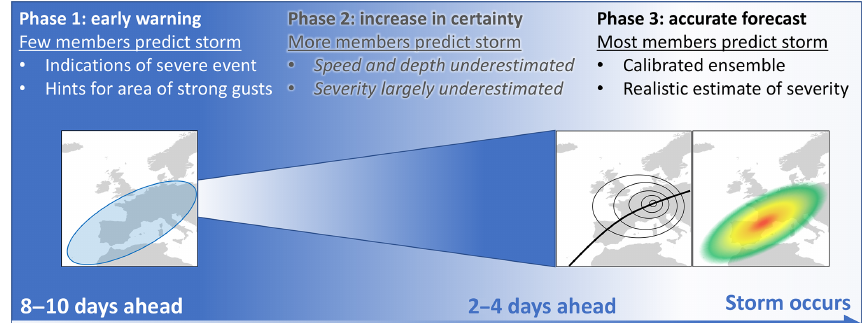
Figure 11. Summary of the expected skill of an ensemble prediction system for the forecast of severe European winter storms, from long to short forecast lead times separated in three phases. The schematic refers to the three methods depicted in Fig.